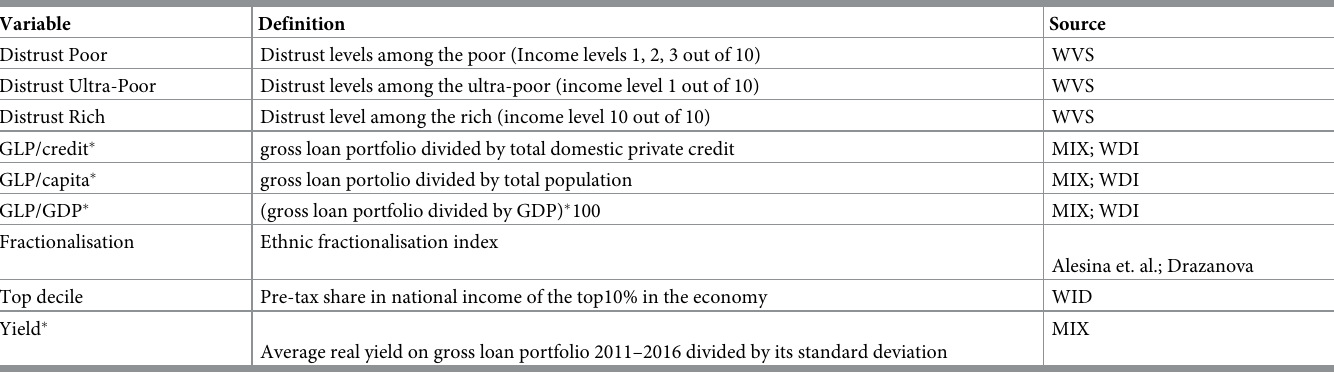
Table 1. Variables.